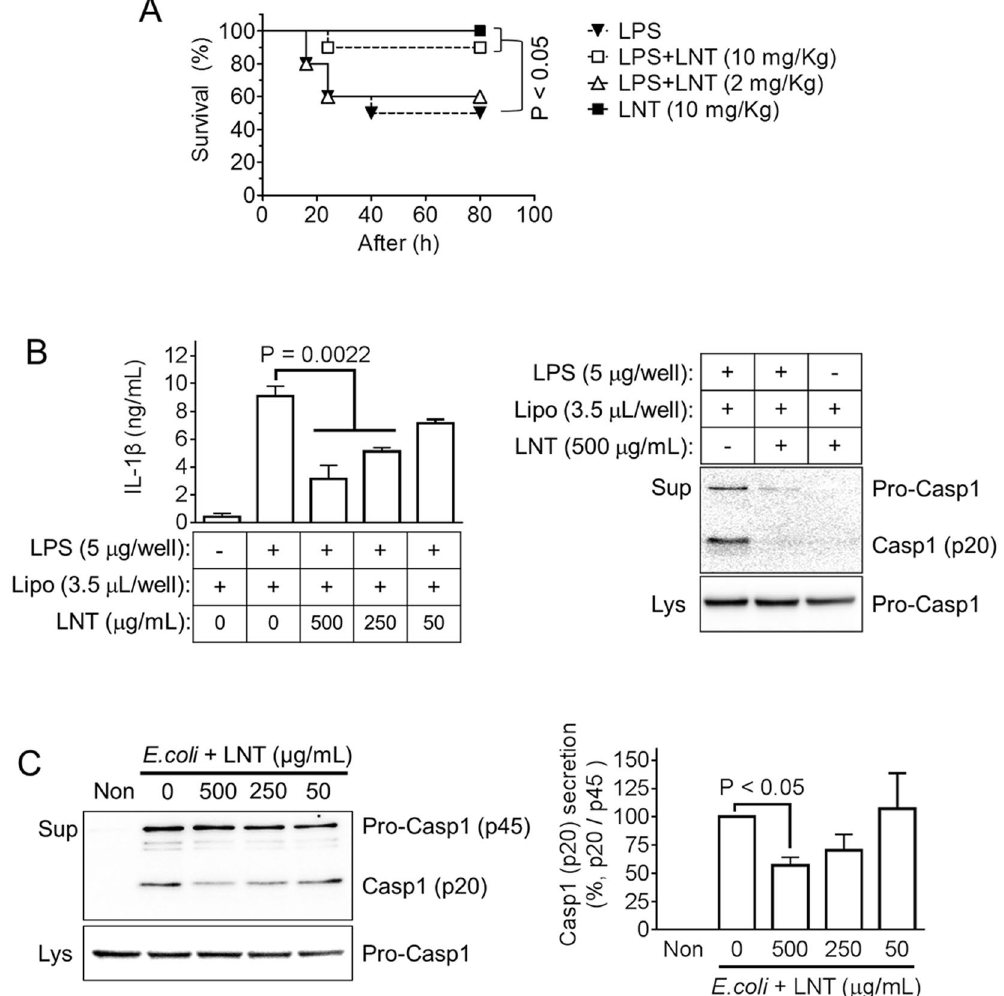
Figure 6. Effect of lentinan on endotoxemic models. ( A ) Mice (n = 10 per group) were intraperitoneally (ip) injected with LPS (25 mg/kg) and/or lentinan (LNT) as indicated. Survival rates were observed at the indicated times. ( B ), LPS-primed BMDMs were transfected with LPS to activate non-canonical inflammasome in the presence of LNT as indicated. IL-1 β and Casp1 secretion was analyzed by ELISA and immunoblotting. ( B ) LPS- primed BMDMs were infected with E . coli . (MOI = 10) to activate non-canonical inflammasome in the presence of LNT as indicated. Secretion of Casp1 was analyzed by immunoblotting, and the right bar graph indicates relative band density. Bar graphs present the mean ± SD. Lipo, Lipofectamine 2000 TM